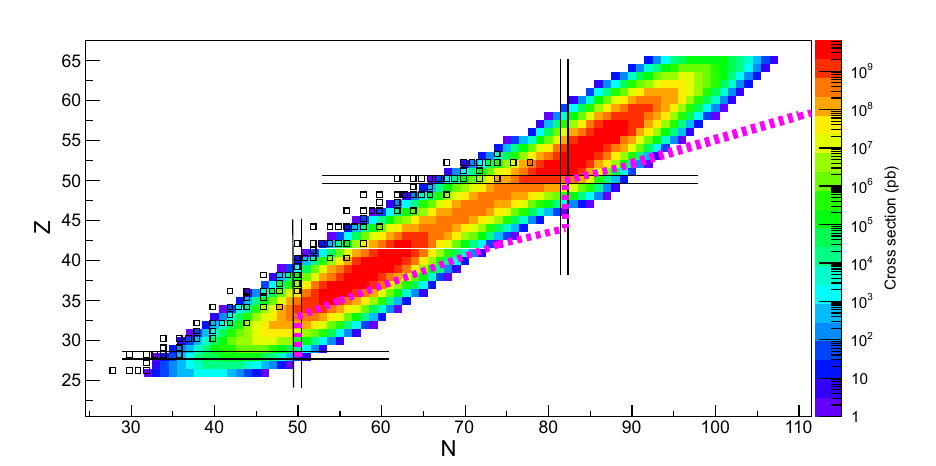
Figure 1. (Color online) Isotopic cross sections of fragments produced by photofission of 238 U at 14 MeV, calculated by the GIF 238 U parametrization (see Ref. [4] for details). The stable nuclei are donated by open squares. The dotted lines show the position of the r-process path [5]. The proton and neutron closed shells are indicated with the black solid lines.